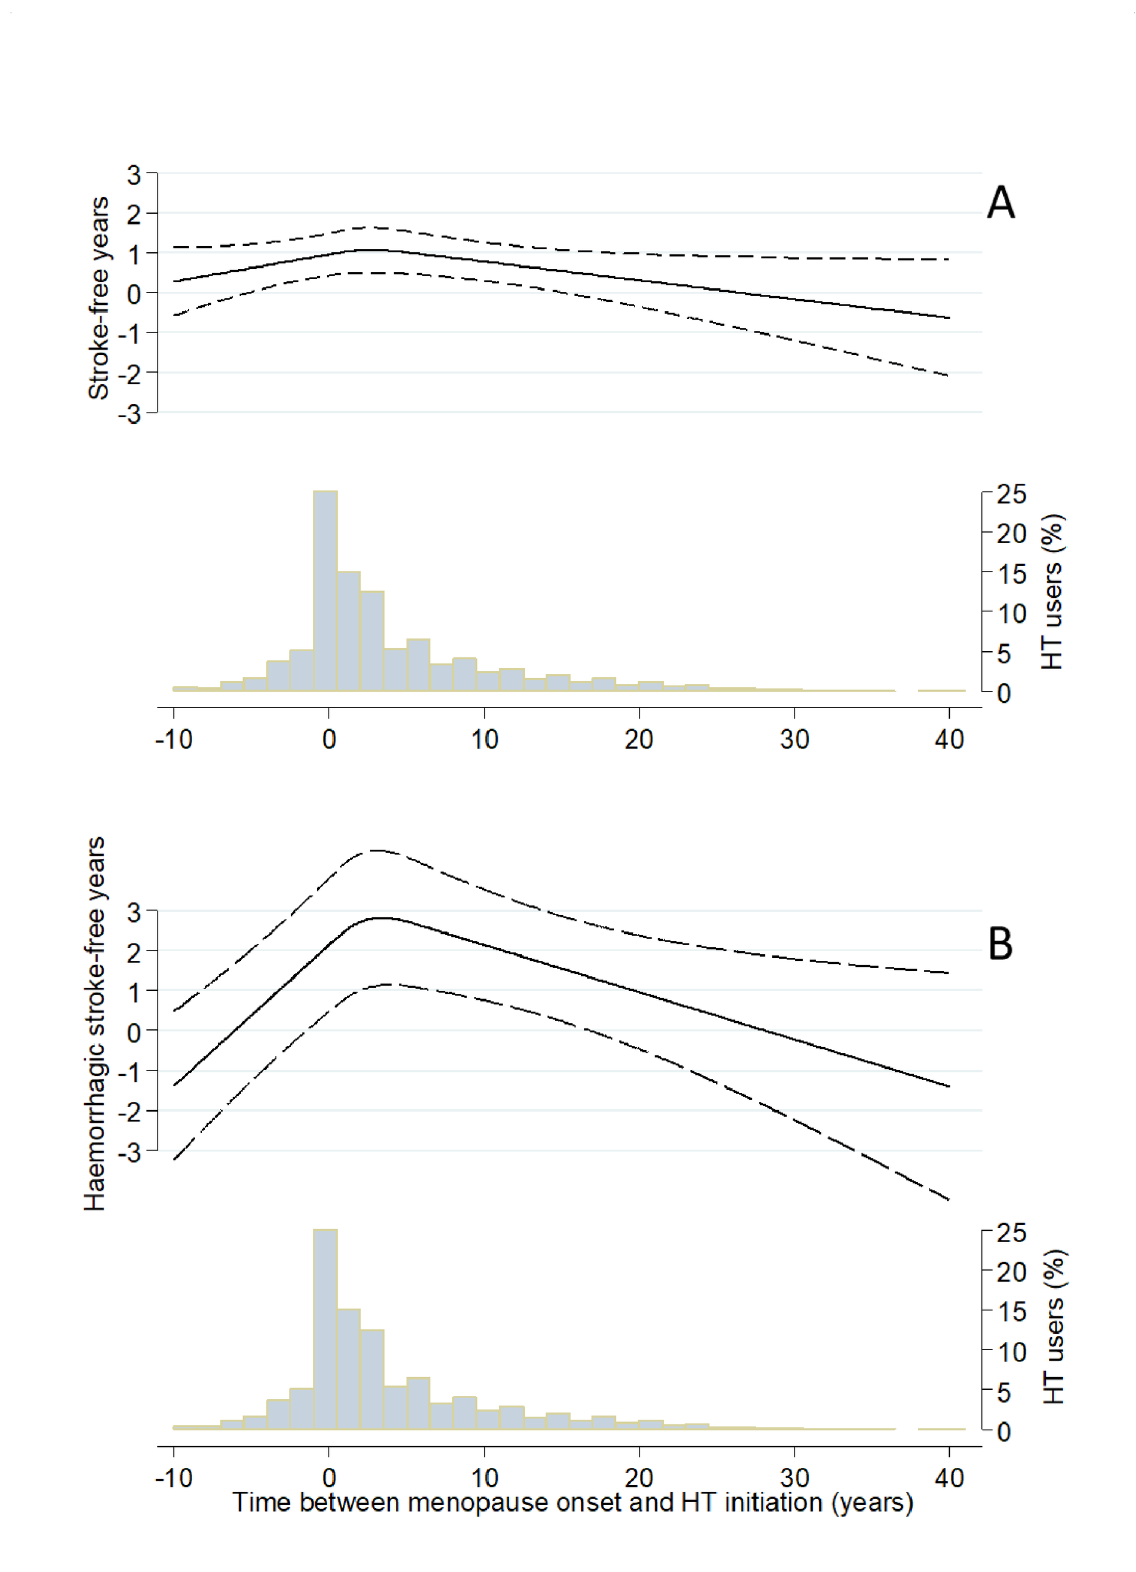
Fig 3. Percentile difference (PD) between users and never users, modelled as a function of time of postmenopausal hormone therapy (HT) initiation using restrictedcubic splines and adjusting for age at baseline, level of education, PLOS Medicine| https://doi.org/10.1371/journal.pmed.1002445 November17,